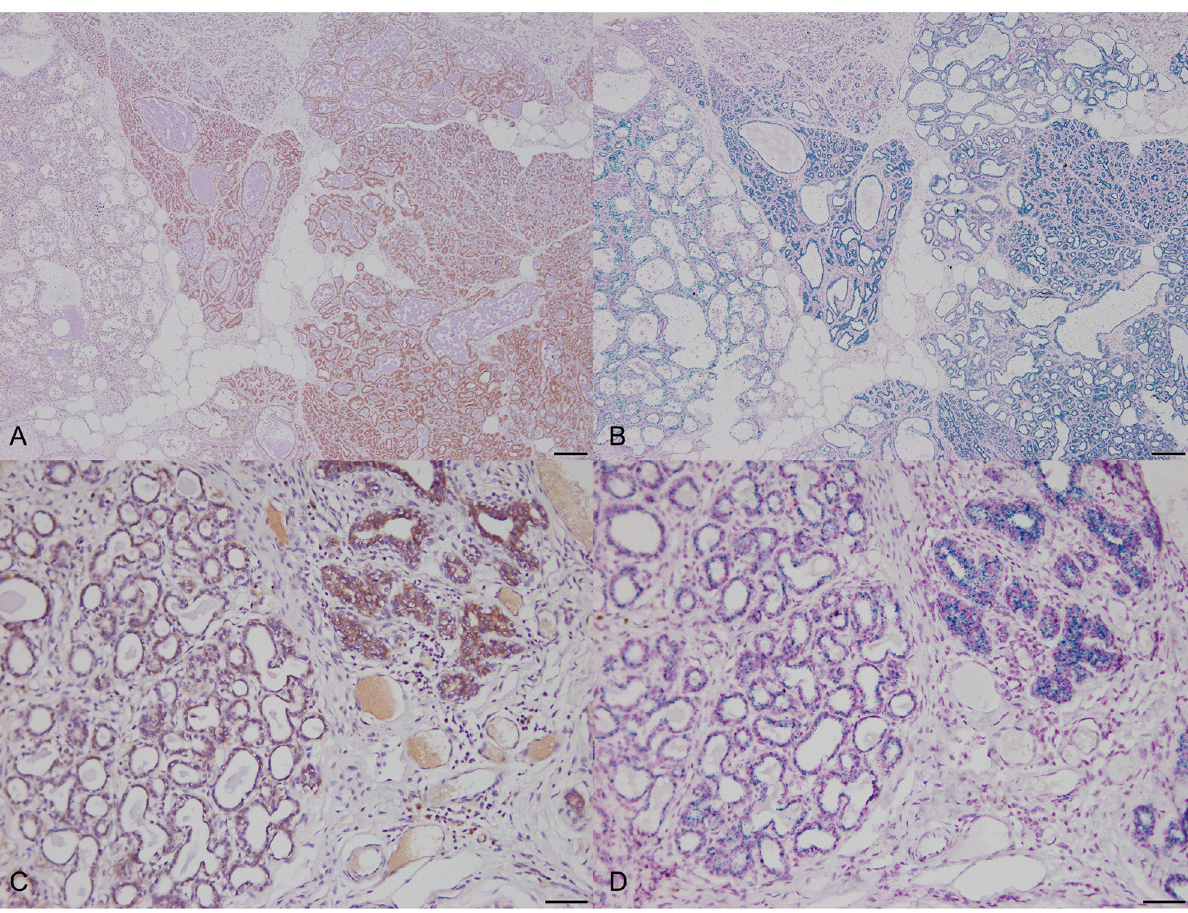
Fig 4. HER2 expression in adjacent serial section of non-neoplastic regions. (A) Strong membrane staining pattern (3+) in right sides of mammary gland hyperplasia samples by IHC, 40 × , bar = 200 μ m. (B) Expression of HER2 mRNA dots was observed in the section of serial to Fig 4A by RNA-ISH, 40 × , bar = 200 μ m. (C) Moderate HER2 staining was observed in the adjacent normal mammary gland in CMT by IHC, 200 × , bar = 50 μ m. (D) Expression of HER2 mRNA dots was observed in the section of serial to Fig 4C by RNA-ISH, 200 × , bar = 50 μ m.